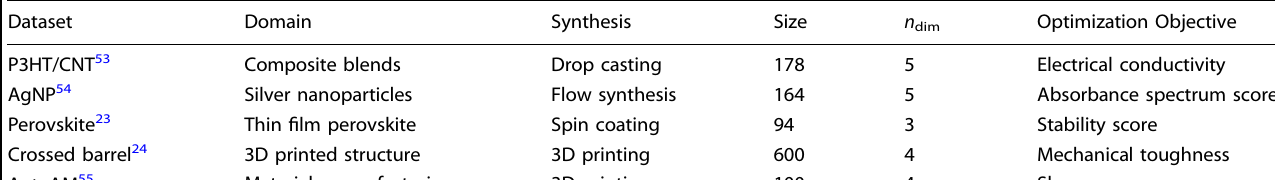
Table 1. Description of experimental materials science datasets.